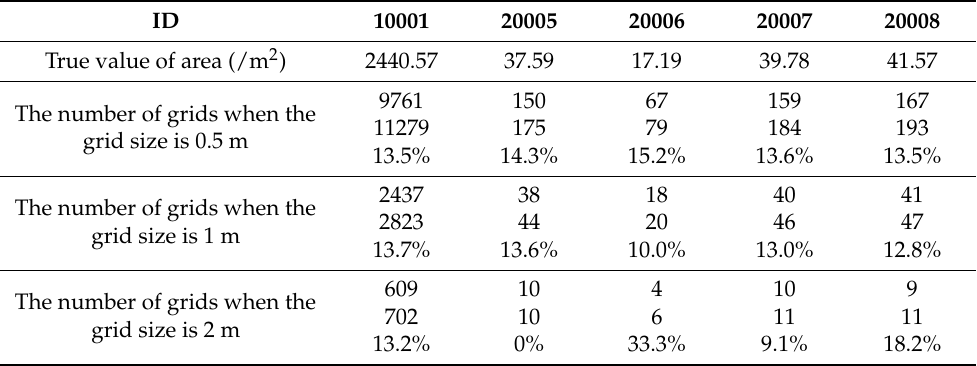
Table 2. The number of grids in the experimental